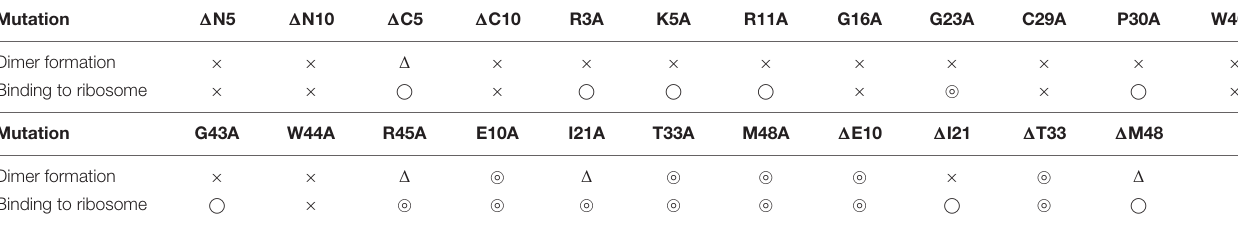
TABLE 2 | Evaluation of dimer formation and ribosome binding by RMF.